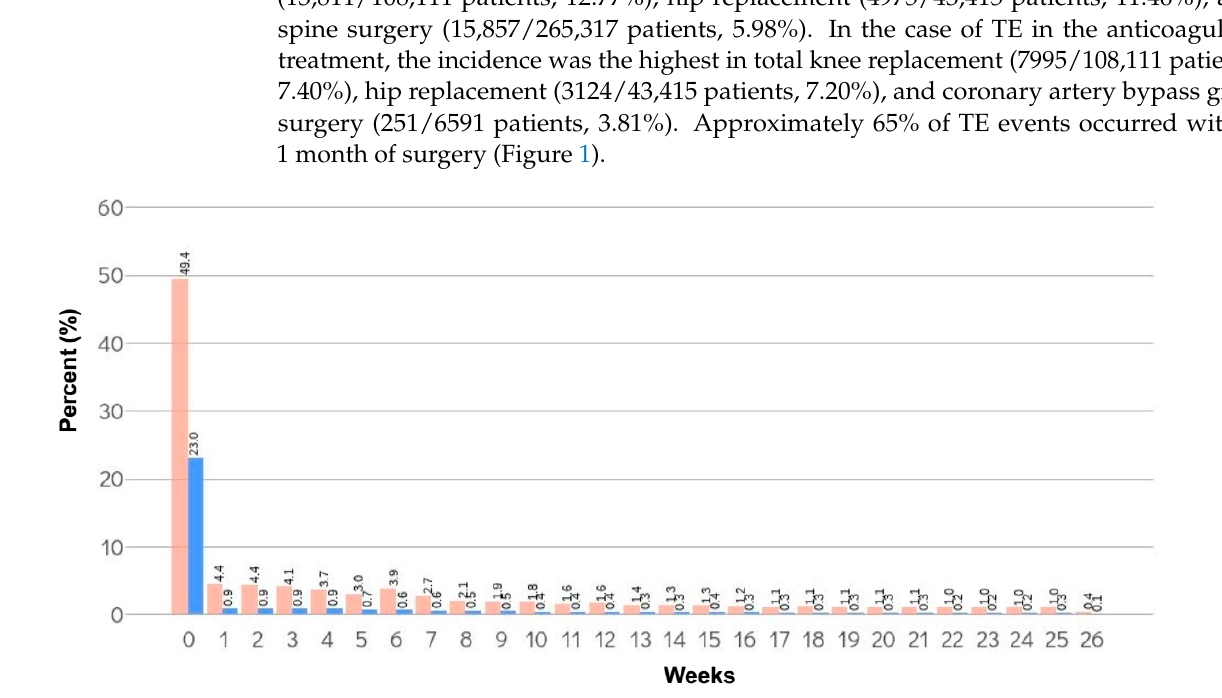
Figure 1. Distribution of TE events within 6 months from the date of surgery. The distribution of TE events within 6 months from the date of surgery is shown as the percentage from a total of 60,683 patients with TE (pink bar: total claimed TE, blue bar: TE with anticoagulant treatment).